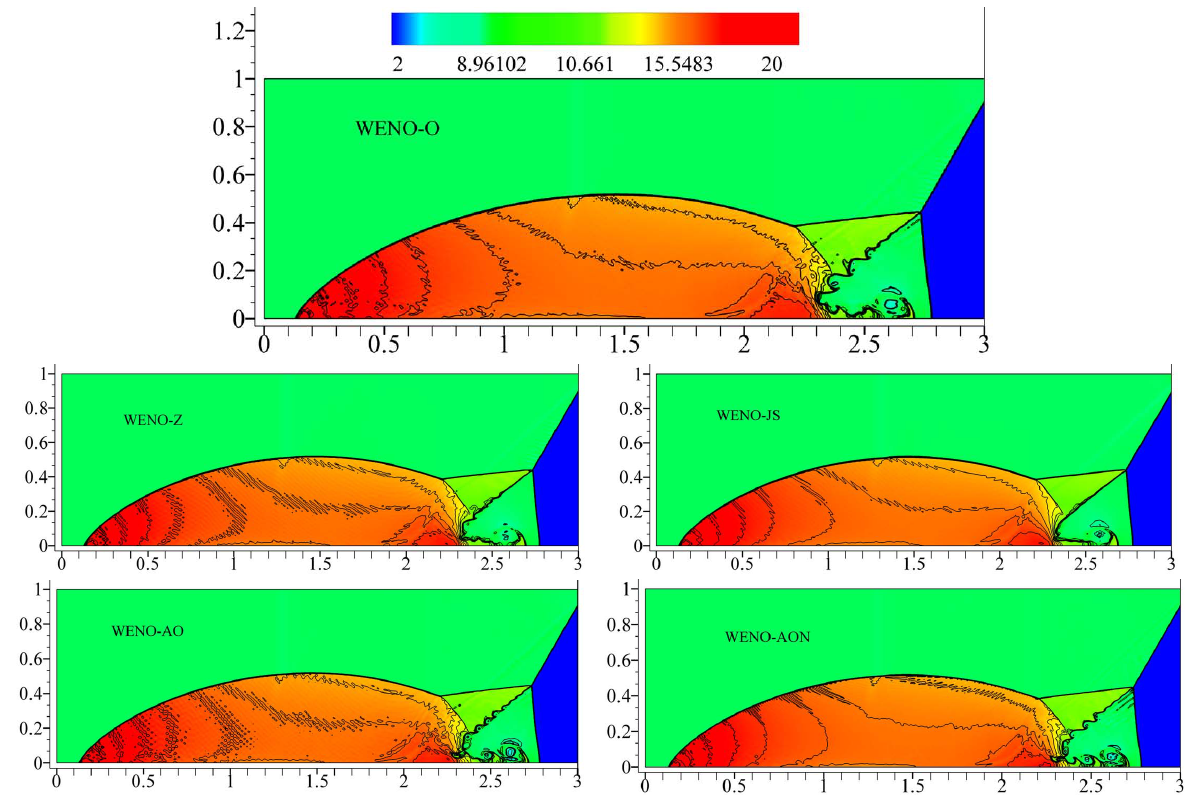
Figure 19. Equally spaced contours of two-dimensional double-Mach reflection of strong shock of Example 7 (Section 6.3.1) at time of 0.2, CFL = 0.475, [ 0,4 ] × [ 0,1 ] 1600 ×